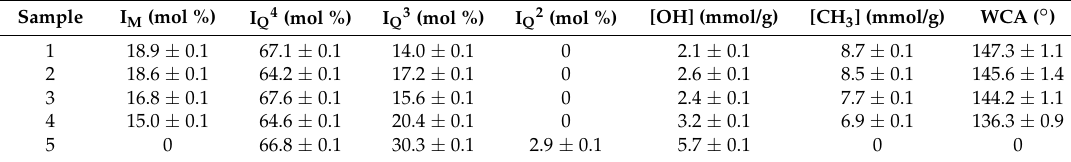
Table 4. Solid state 29 Si MAS NMR fitting results and water contact angles of silica